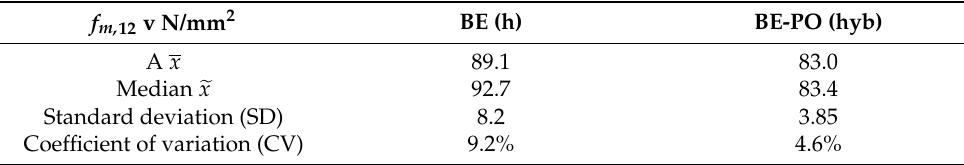
Table 1. Bending strength of the glue-laminated beams.